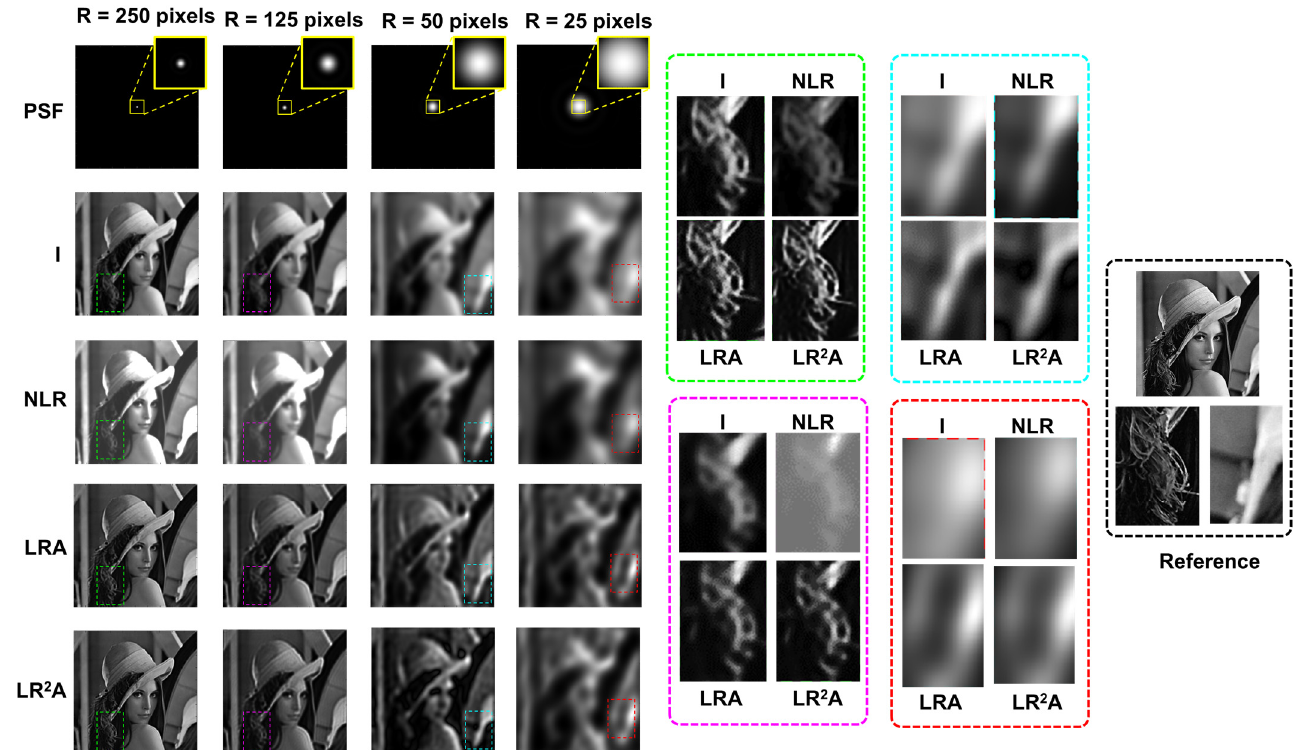
Figure 3. Deblurring results of NLR, LRA, and LR 2 A for di ff erent radii of the aperture R = 250, 125, 50, and 25 pixels.